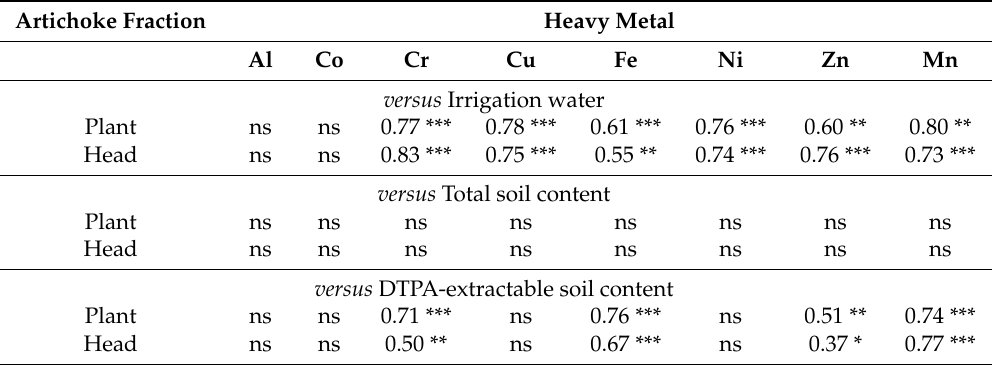
Table 4. Pearson’s correlation coefficient values between the heavy metal content in artichoke fraction (plant or yield/head) and irrigation water and soil heavy metal